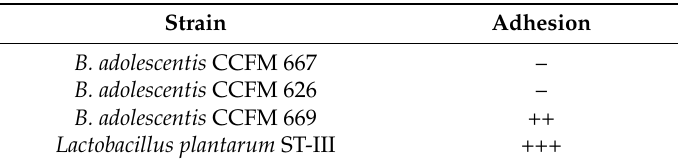
Table 2. Adhesion of different bacteria to HT-29 cells.